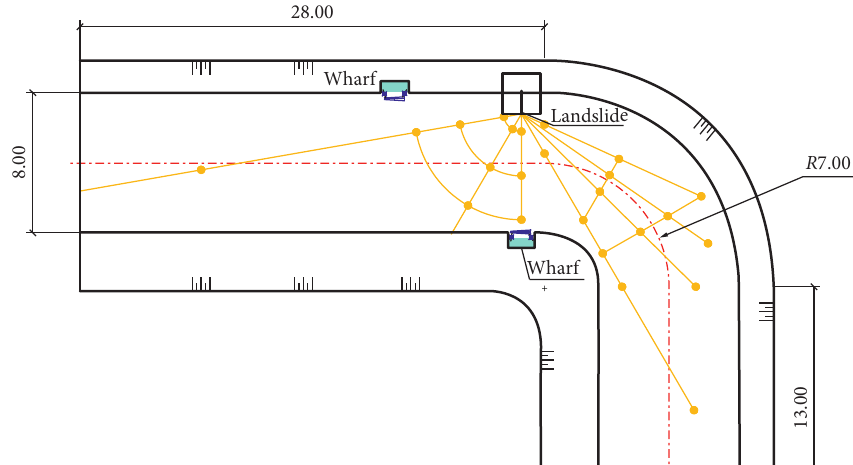
Figure 1: The research design of this